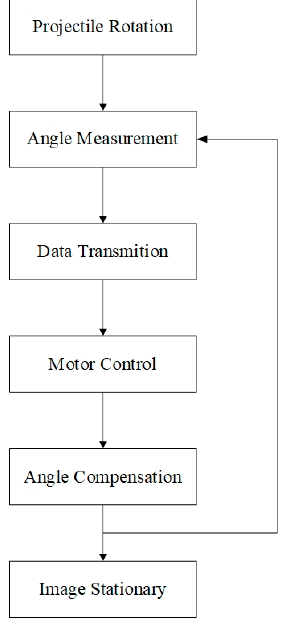
Figure 2. Workflow of the mechanical stabilization.